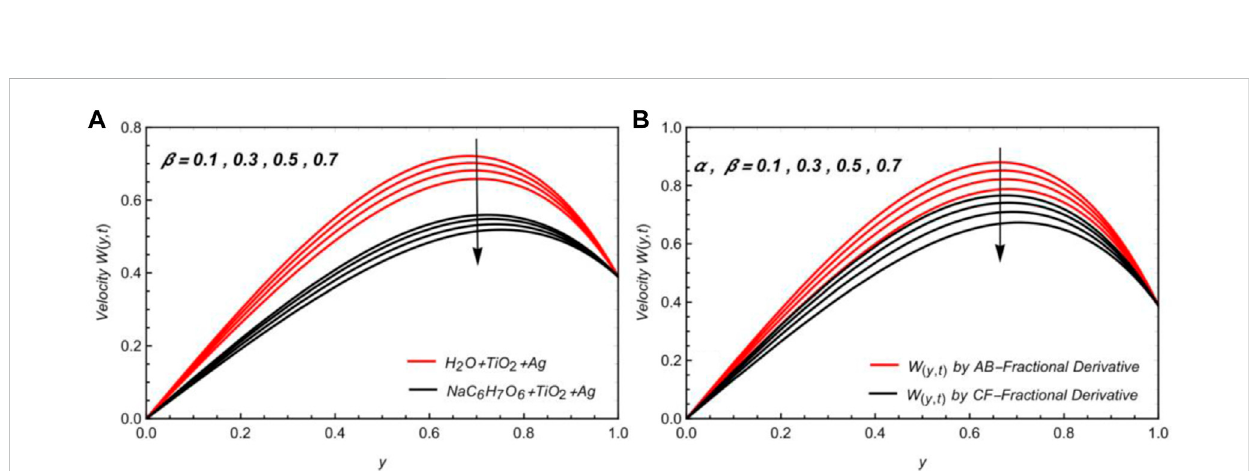
FIGURE 4 W ( y , t ) due to variation in α , β with φ (cid:2) 0 . 02 , M (cid:2) 1 . 65 , Ra (cid:2) 1 . 2 , K eff (cid:2) 0 . 7 , Gr (cid:2) 8 . 0 , Gm (cid:2) 6 . 3 , β 1 (cid:2) 1 . 5 , θ (cid:2) π /4 , and t (cid:2) 0 .